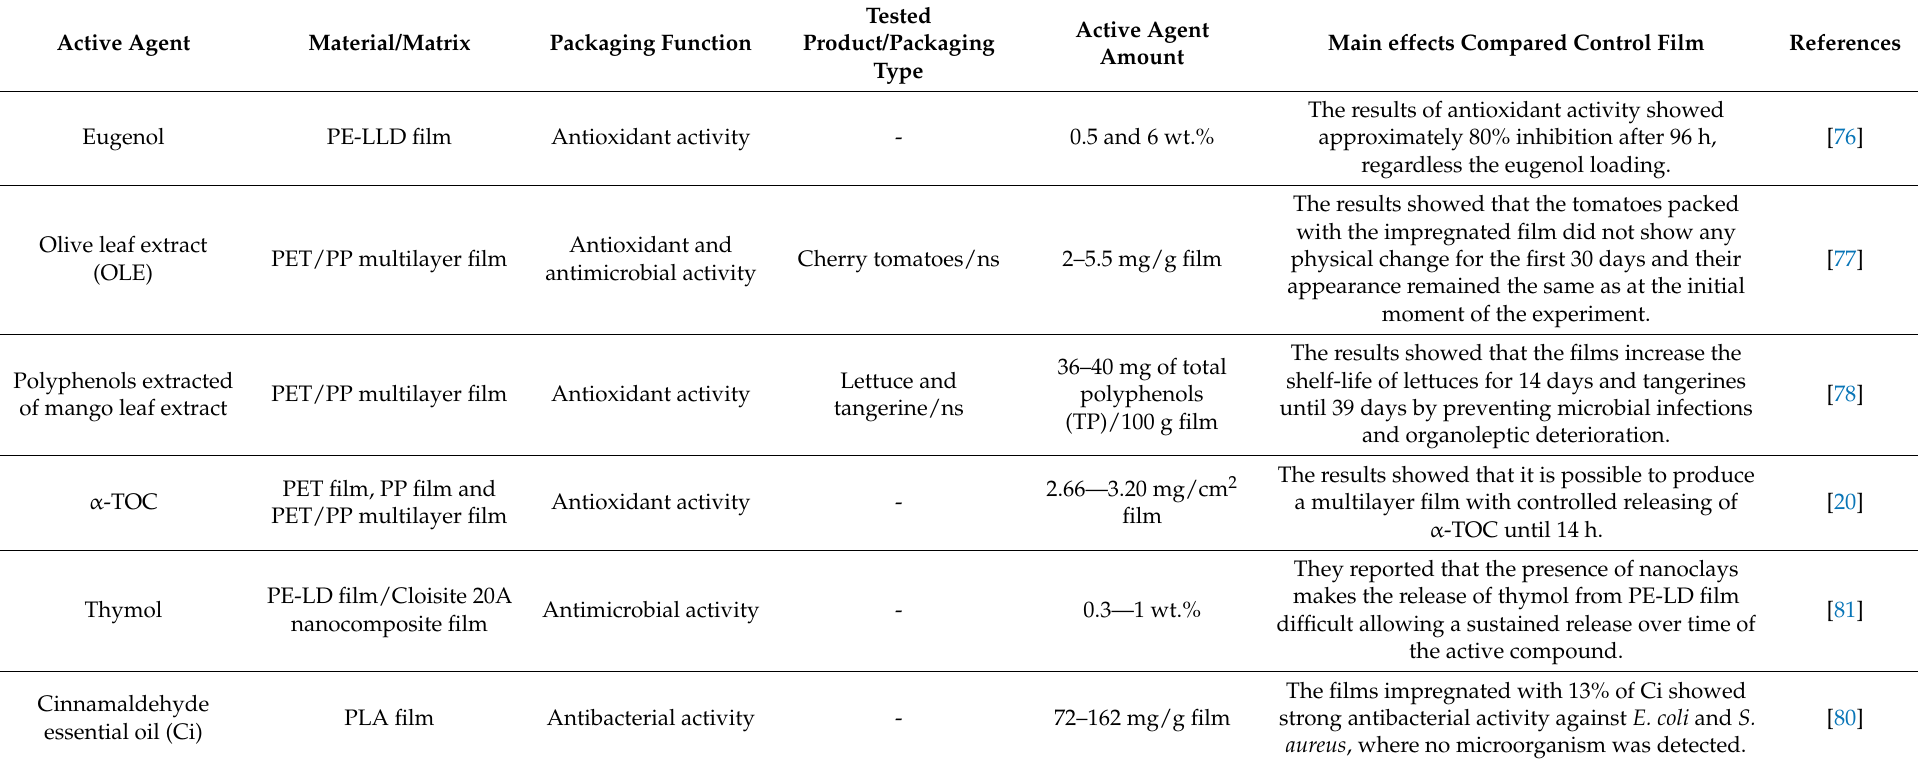
Table 4. Active agent sorption on the surface of the flexible films using the SC-CO 2 impregnation